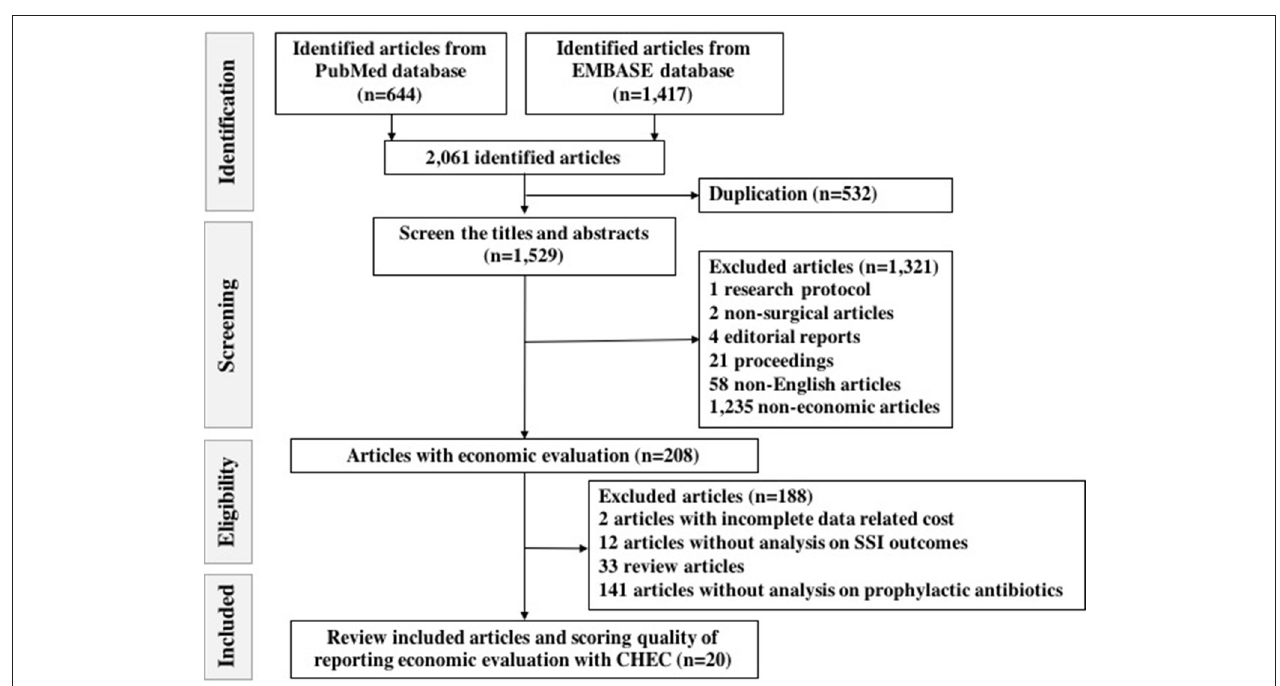
FIGURE 1 | Flow chart of search strategy on identifying eligible and included studies with standard report of the Preferred Reporting Items for Systematic Reviews and Meta-Analyses (PRISMA).